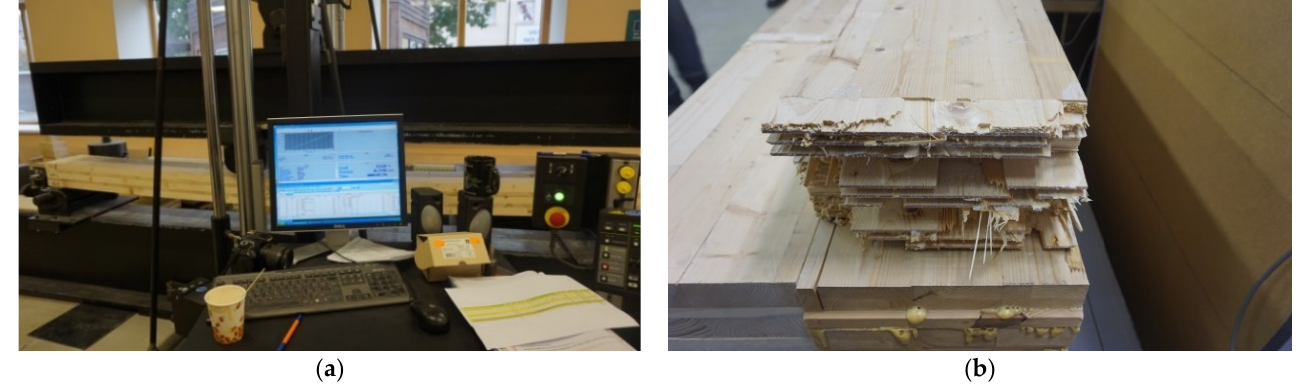
Figure 7. ( a ) Performance of sample measurements ( b ) Analysis of the